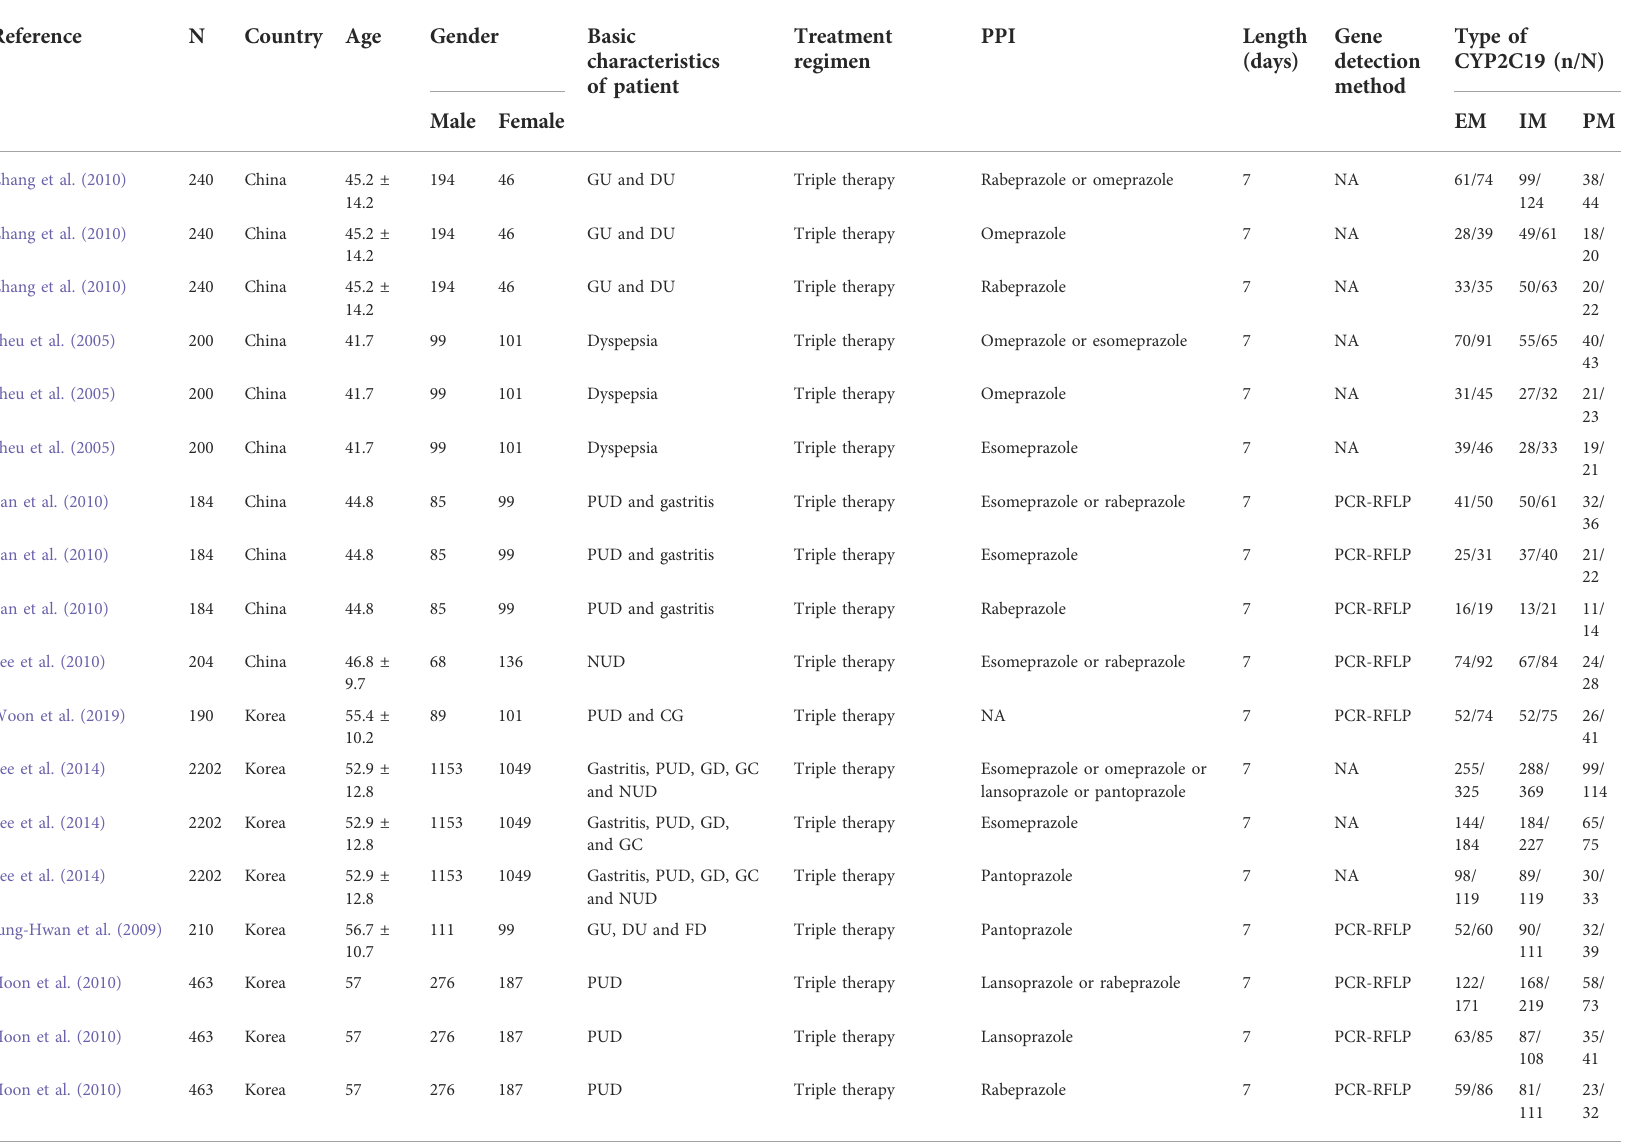
TABLE 2 Summary of articles included in the